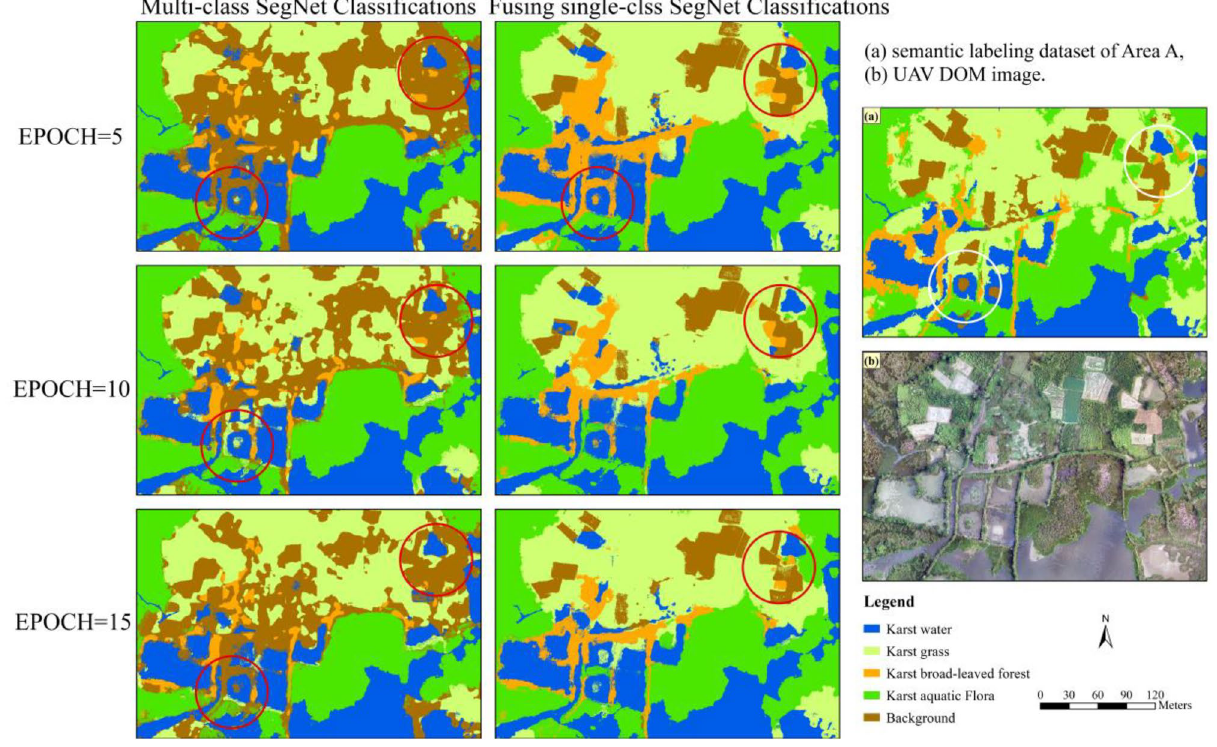
Figure 7. SegNet-based classifications for karst wetland vegetation with different EPOCH values. ArcGIS 10.6 software (http:// www. esri. com/ softw are/ arcgis) was used to process and map the data by first author (T. D.) and